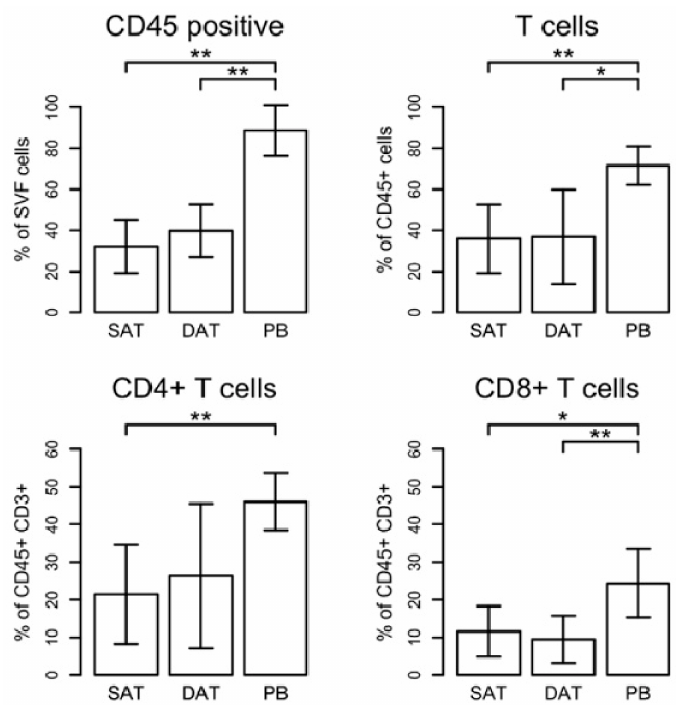
Figure 5. Analysis of T-cells in SAT, DAT, and peripheral blood cells (PB). Gating strategy is shown in Figure 4A. The percentages of T-cells were calculated based on the numbers of CD45 + cells. CD8 + T-cells were discriminated from CD4 + T-helper cells on the basis of expression of CD8 marker. CD4 + T-cells were determined as CD8 - cells. Results represent data from six patients and are expressed as mean ±